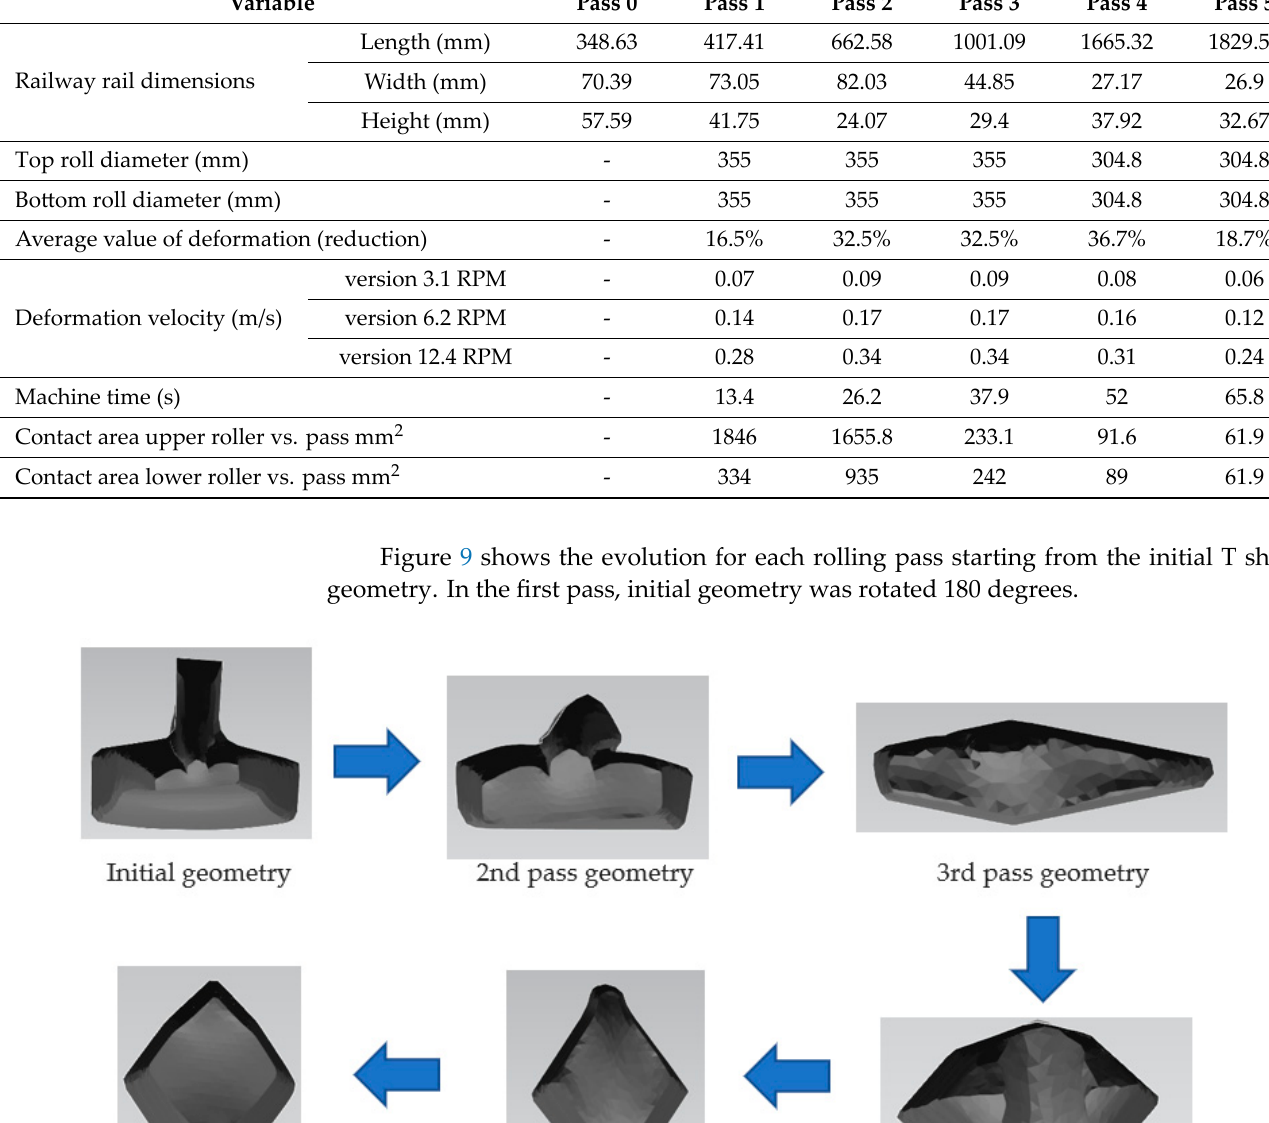
Table 3. Basic information about DEFORM simulations for each pass.